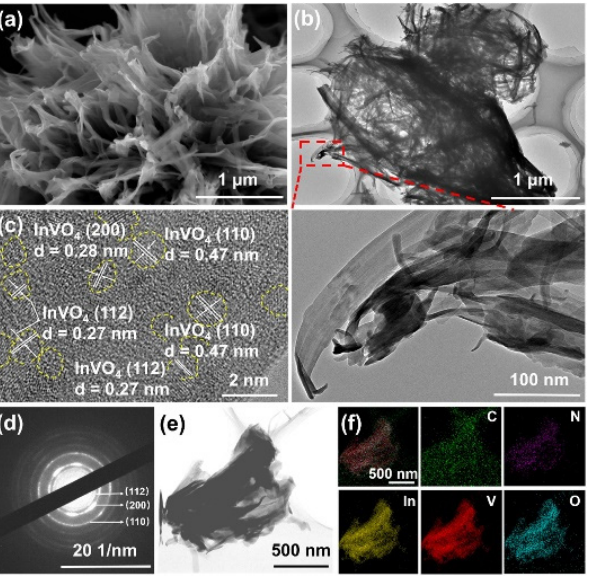
Figure 19. SEM image ( a ), TEM images ( b ), HRTEM image ( c ), SAED pattern ( d ), HAADF − STEM image ( e ) and corresponding EDX elemental mapping images ( f ) of InVO 4 /CN − II.